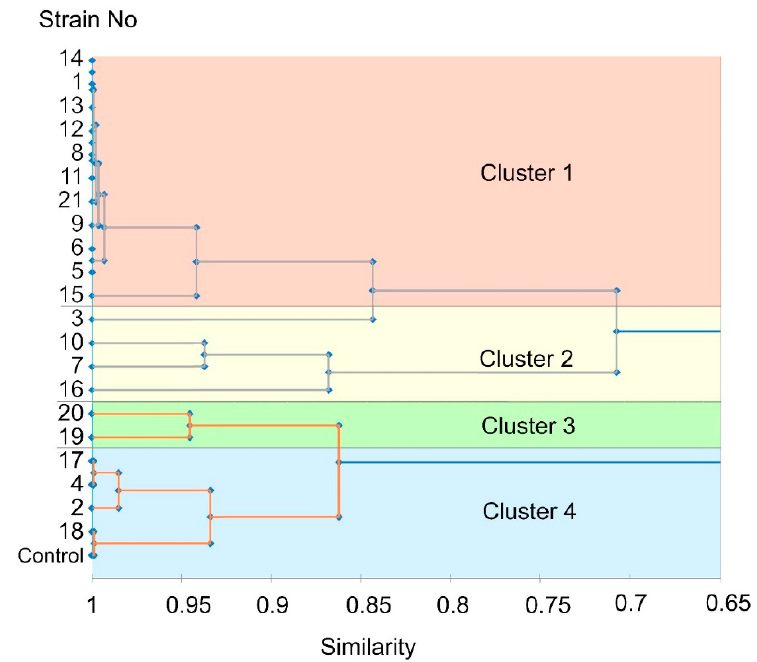
Figure 14. Agglomerative hierarchical clustering of the isolated Microdochium nivale strains according to their virulence expressed as the degree of symptom manifestation on the infected rye plants (root length, shoot length, the weight of shoots of 10 plants, the weight of roots of 10 plants, the number of roots, the number of leaves, the percentage of plants with brownish roots, the percentage of plants with stem necrosis, and the percentage of plants with leaf necrosis). The clustering was performed using R, method “complete”. Control—noninfected plants. Clusters were delineated at an arbitrary level of r = 0.65.